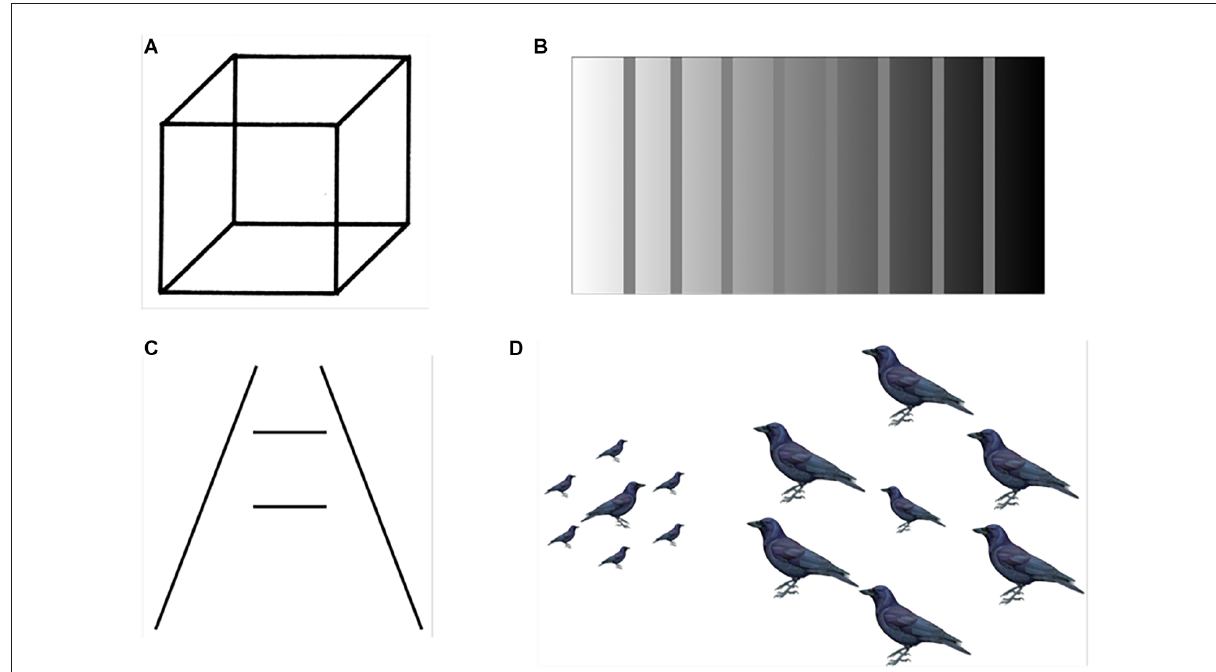
FIGURE7 (A) Necker cube, (B) Simultaneous contrast, (C) Ponzo figure, and (D) an ecological version of the Ebbinghaus figure.